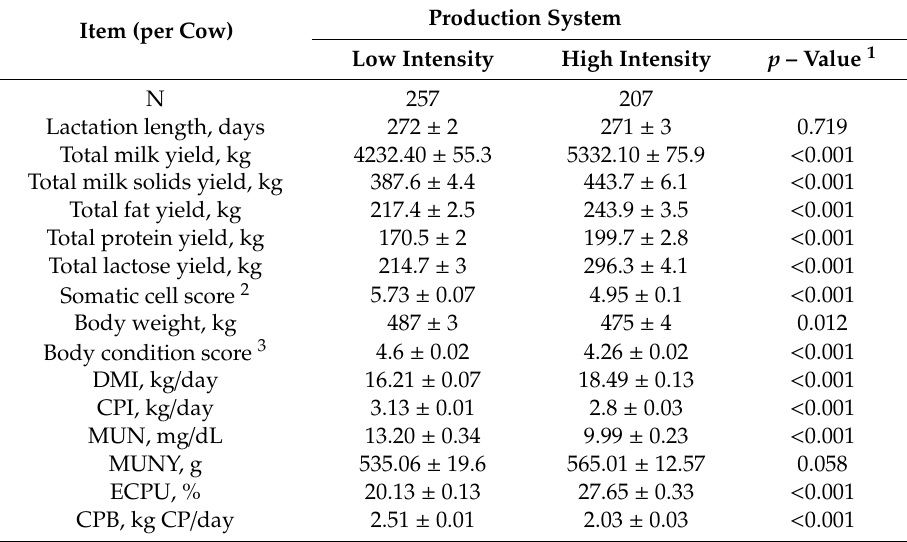
Table 5. Least squares means ( ± standard errors) of lactation length, total yield of milk, milk solids, fat, protein and lactose, SCS, body weight and body condition score, dry matter intake (DMI), crude protein (CP) intake (CPI), milk urea nitrogen (MUN) and MUN yield (MUY), e ffi ciency of CP utilisation (ECPU), and CP balance (CPB) of grazing cows throughout a full lactation in two contrasting pasture-based dairy production